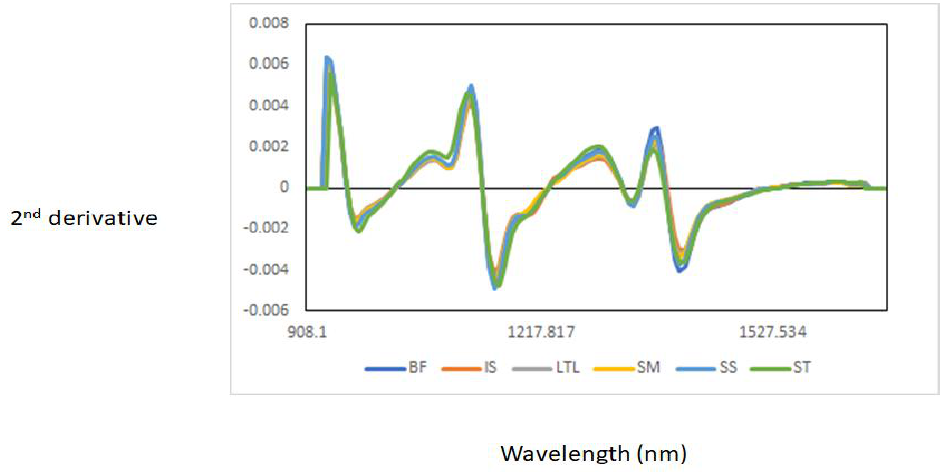
Figure 3. Near-infrared second-derivative average spectra of each of the intact goat muscle samples analysed.